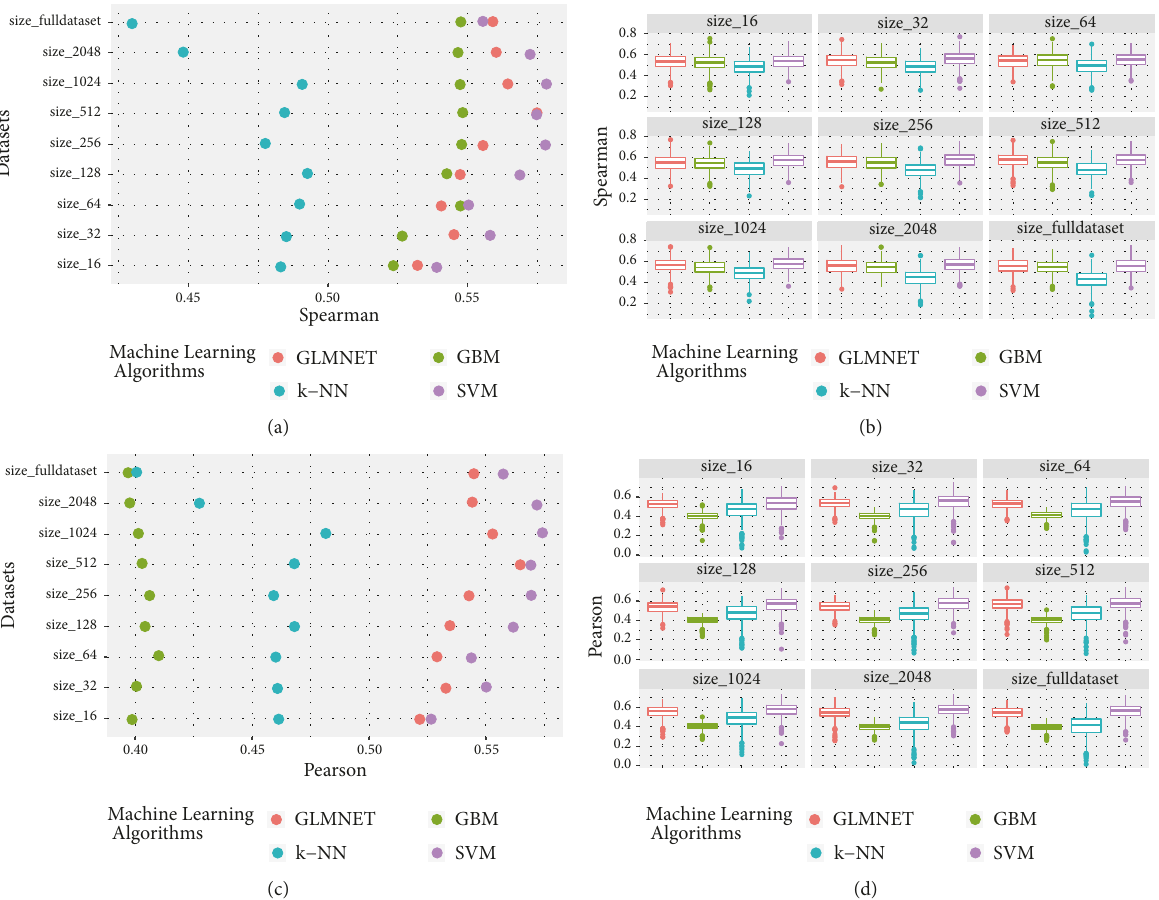
Figure 5: Results obtained for the four models proposed and optimised by hyperparameterisation. On the right, the mean values for Spearman’s (top) and Pearson’s r (bottom) are shown. On the left, the distributions of all 50 independent runs for each optimum model (Spearman top and Pearson bottom) are shown with different input sizes tested using